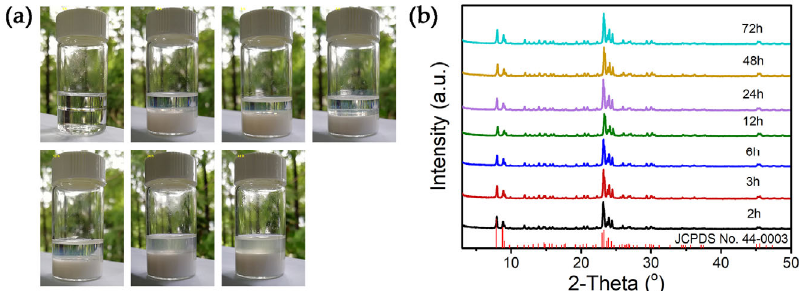
Figure 14. ( a ) Time ‐ dependent digital photographs of ZSM ‐ 5 ‐ 100 ‐ 200 after standing for 0.5 min and ( b ) XRD patterns of the corresponding solid products collected at different time points in the course of the crystallization process.